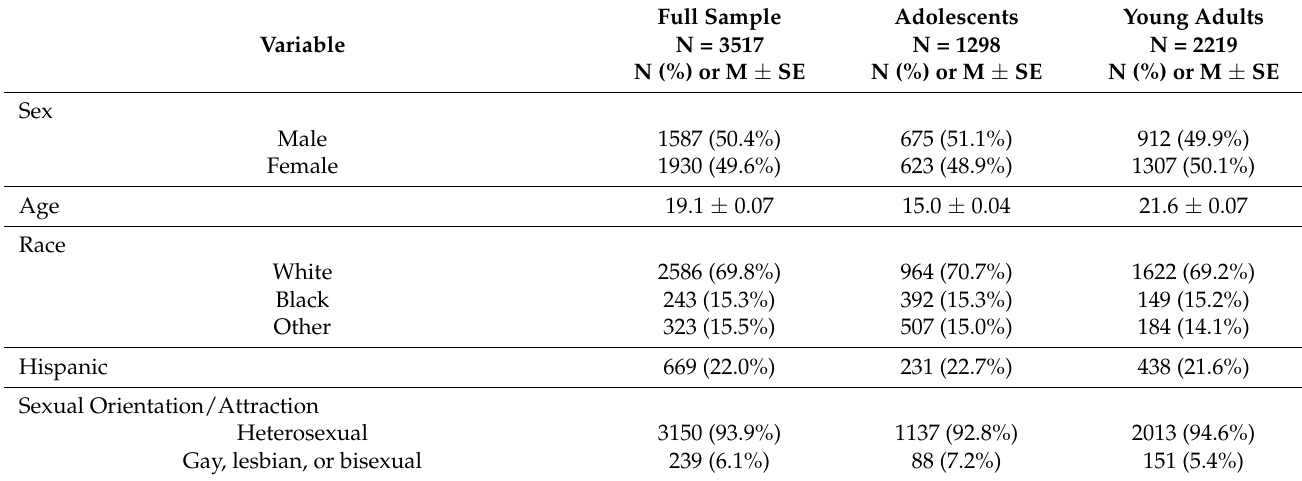
Table 1. Demographics and cigarillo user